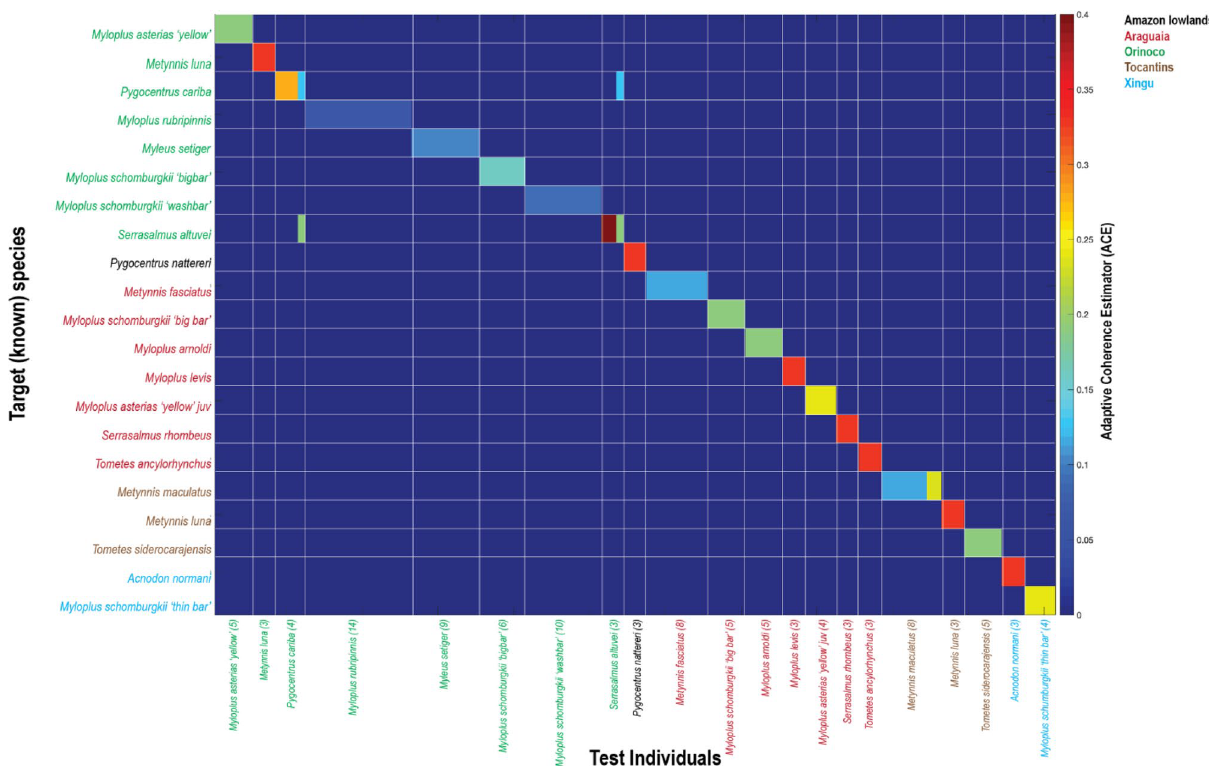
Figure 7. Adaptive Coherence Estimator (ACE) spectral signature ‘matching’. Taxa on the x axis indicate the target, or ‘known’ species. Taxa on the y axis are the test individuals that are matched to the most similar ‘known’ species through ACE. The numbers in brackets indicate the number of individuals of a given species included in the test set. Each specimen is matched individually. Higher values of ACE indicate a stronger match. Although the strength of the ACE match can vary within species (e.g., Metynnis maculatus ), a species’ ACE value is shown to be more like its own species than even close relatives. The taxa with the lowest ACE matches are typically those with the broadest geographical ranges (e.g., Myleus setiger, Myloplus rubripinnis, Myloplus schomburgkii ‘ wash bar’ Orinoco from the M. schomburgkii species complex) and therefore the greatest potential for cryptic lineages through low population